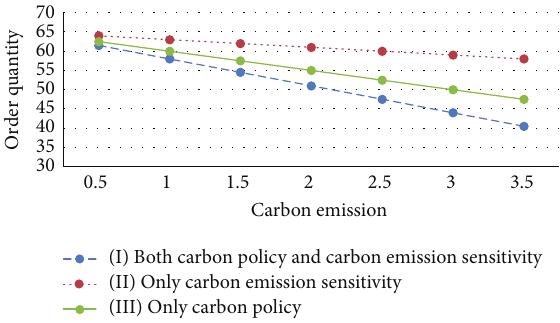
Figure 3: Effect of transportation carbon emission on retail prices.